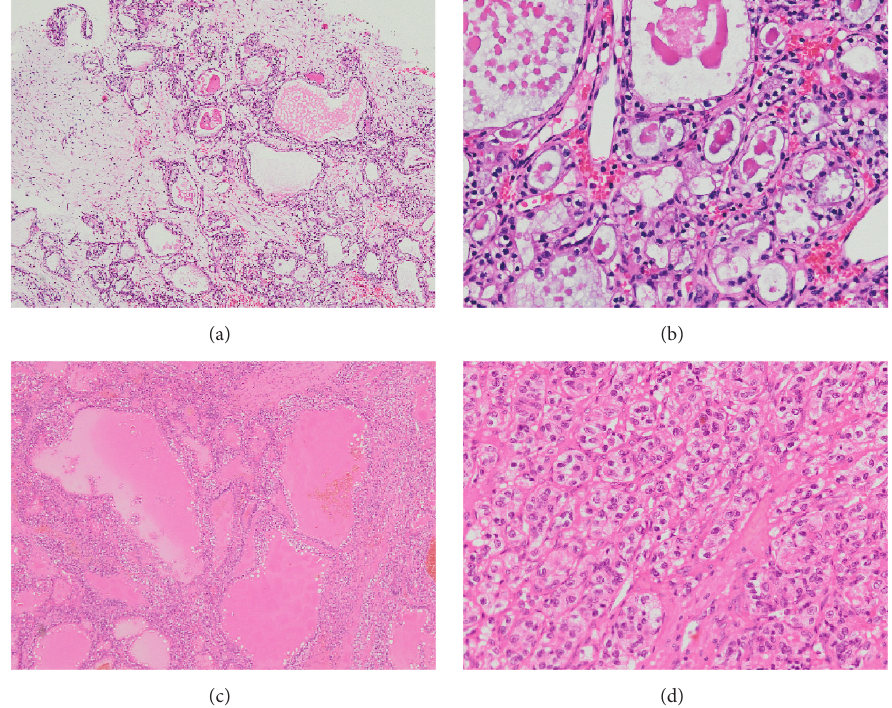
Figure 1: Haematoxylin and eosin (HE) stains of the sinonasal tumour (a) × 4 and (b) × 20 and renal tumour (c) × 4 and (d) × 20.